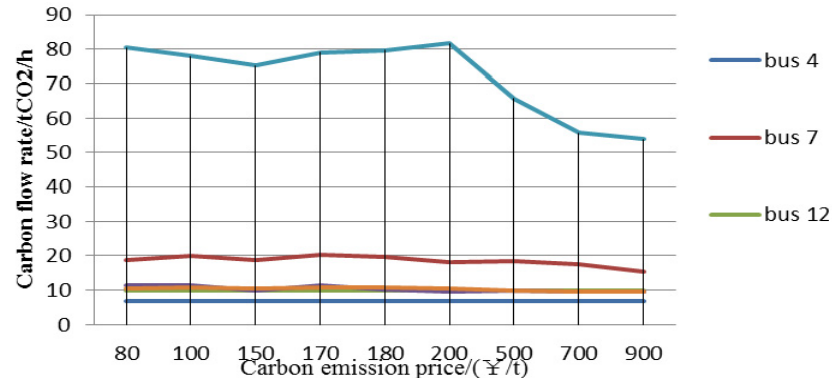
Figure 6. The variation tendency of the carbon flow rate with two large consumers in the